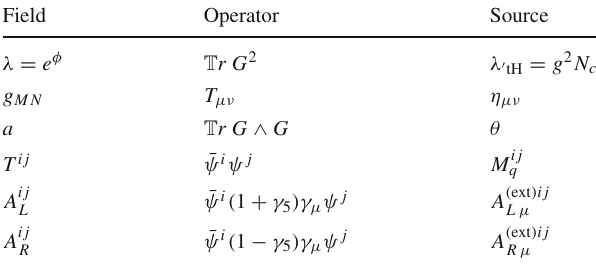
Table 1 The dictionary of V-QCD. Here η μν is the metric of field theory, θ is the Yang–Mills θ -angle, M q is the (possible complex) quark mass matrix, and the external gauge fields contain chemical potentials and generalizations of electric and magnetic fields. See Appendix A for the precise coupling between QCD and V-QCD